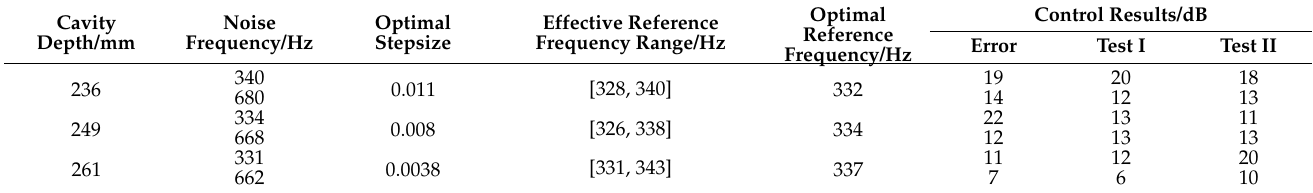
Table 2. Experimental control performance of the flow-induced acoustic resonance